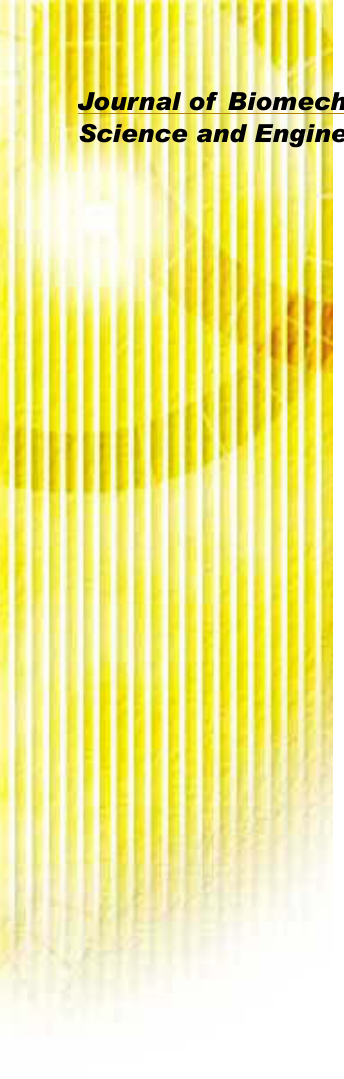
MS mask was removed from the ts of any requisite shape (Fig. at 3 2